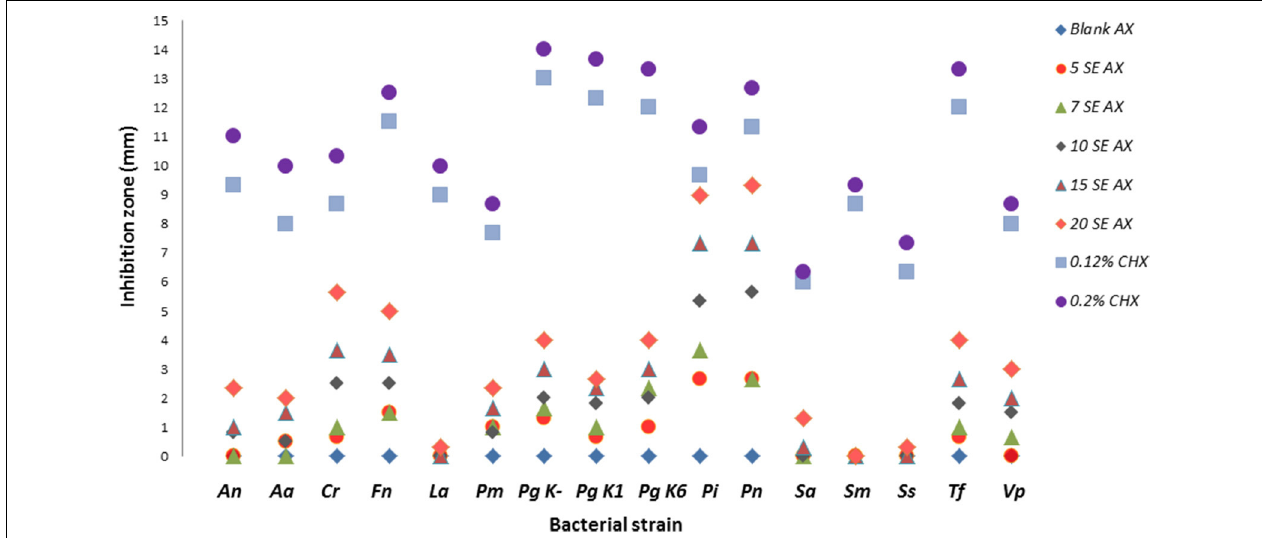
FIGURE 1 | Effects of Ardox-X ® -technology (AX), Blank AX and Chlorhexidine(CHX)oninhibitionoforalbacterialstrainsinagardiffusion assay. Inhibition zone size is expressed in mm (mean of triplicate experiment, except duplicate for Aa and Fn ). The strains ( Table 1 ) used were: Pm, Parvimonas micra ; Porphyromonas gingivalis (Pg K1). (Pg K-). (Pg K6); An,